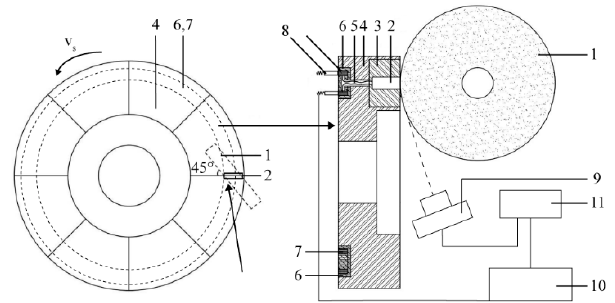
Figure 6. Structure of the temperature measurement system.